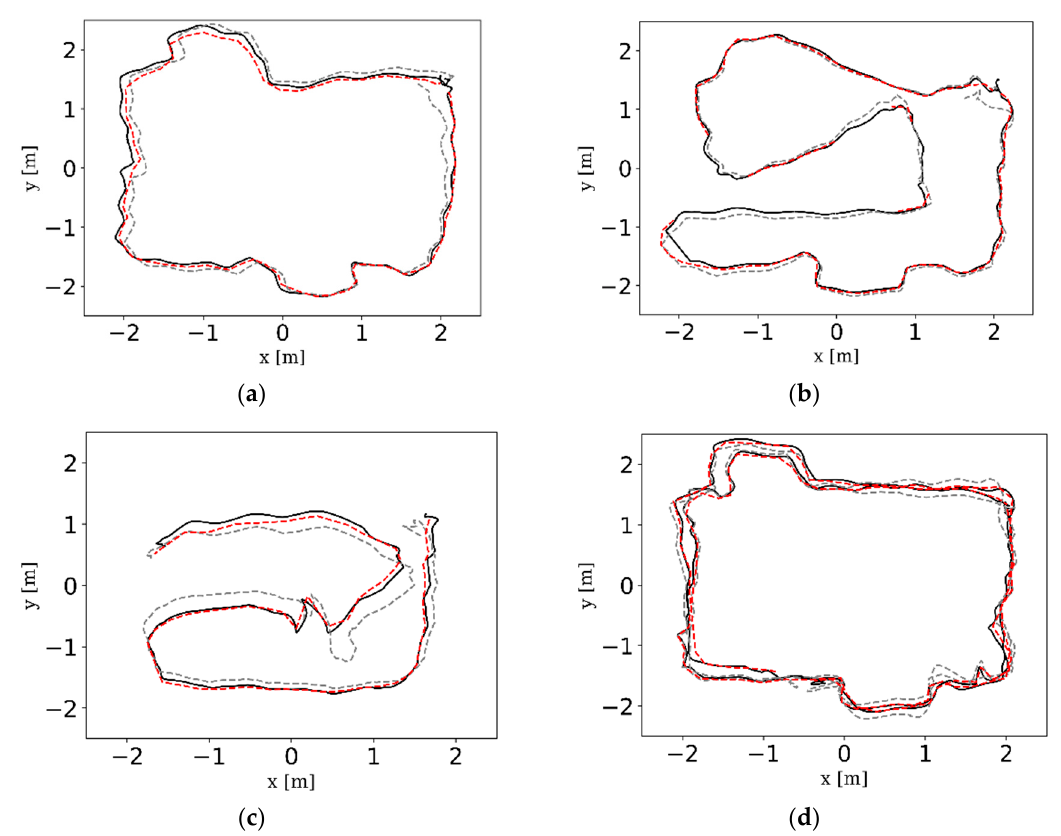
Figure 21. The estimated trajectories of VINS-MKF (Red dotted line), VINS-Mono (Gray dotted line) and the ground truth (Black solid line) on different datasets. ( a ) dyn_1_squ; ( b ) dyn_1_arb; ( c ) dyn_2_static; ( d ) dyn_2_arb.